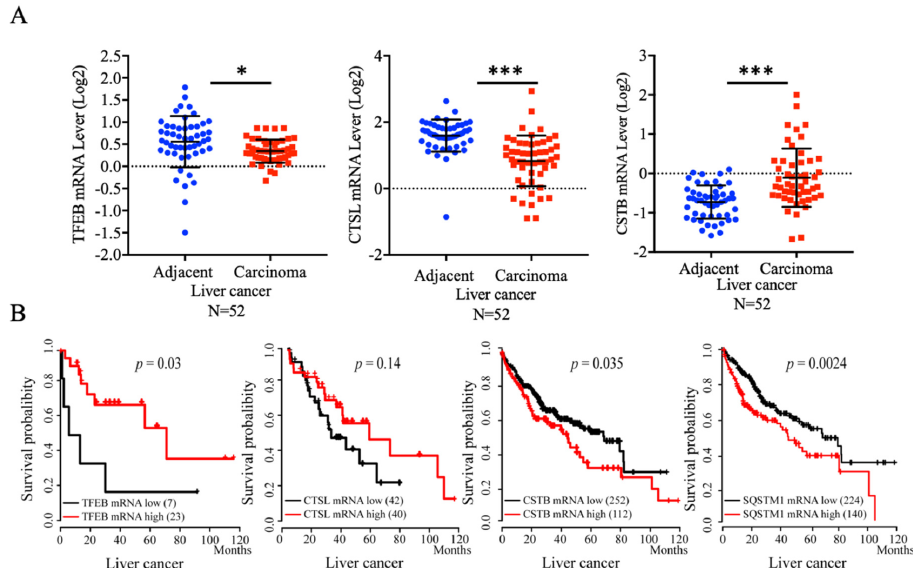
Figure 1. Downregulation of transcription factor EB (TFEB) and lysosomal components are related to hepatocellular carcinoma (HCC) incidence and poor prognosis. ( A ) The mRNA levels of TFEB, cathepsin L (CTSL) or cystatin B (CSTB) in liver cancer samples were retrieved from The Cancer Genome Atlas (TCGA) database; ( B ) The Kaplan–Meier plots of the overall survival (OS) of human liver cancer patients were stratified for TFEB, p62/SQSTM1, CTSL or CSTB mRNA expression levels, and the log-rank test. P values were shown. * p < 0.05 and *** p <